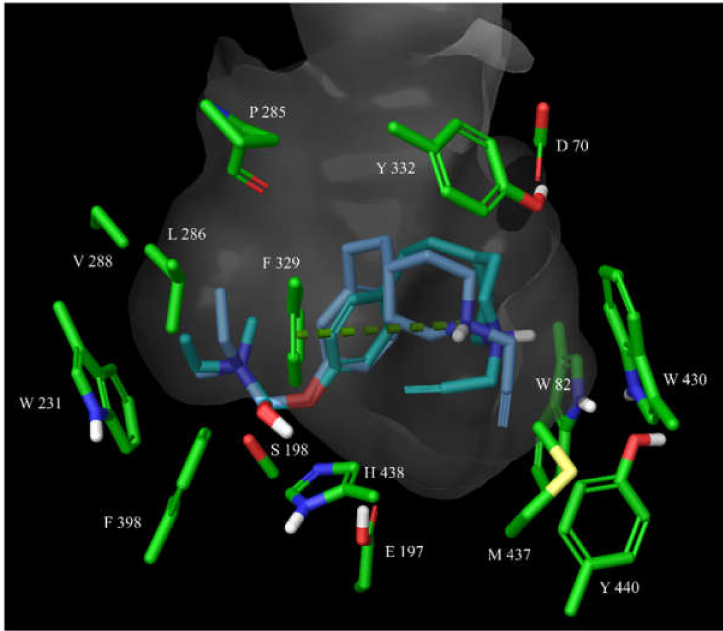
Figure 9. The overlay of docked, covalently bound 14 and 15 (shown as magenta and teal sticks, respectively) in the hBChE active site. The active site is shown as surface with the relevant amino acid residues shown as green sticks. The cation- π interactions of 15 with Phe329 are shown as a green dashed